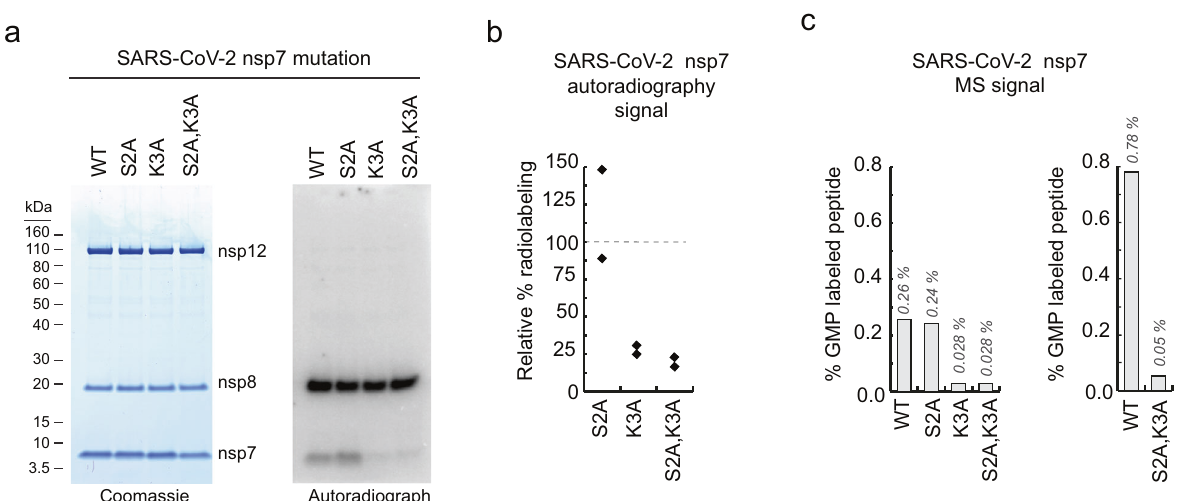
Fig. 4 GMP labeling of SARS-CoV-2 nsp7 mutants. a Radiolabeling of nsp7 was assessed after mutating indicated residues to alanine. A Coomassie- stained SDS-PAGE gel and an autoradiograph are shown. b Quantitation of mutant radiolabeling relative to WT in two separate experiments normalized to nsp8 signal. Individual datapoints (black diamonds) are shown ( n = 2). Data are scaled to WT signal that was set to 100 percent, as indicated by the dotted line. c LC – MS precursor ion quanti fi cation of percent (%) GMP modi fi cation of the SARS-CoV-2 peptide 1 – 14 upon introduction of indicated mutations